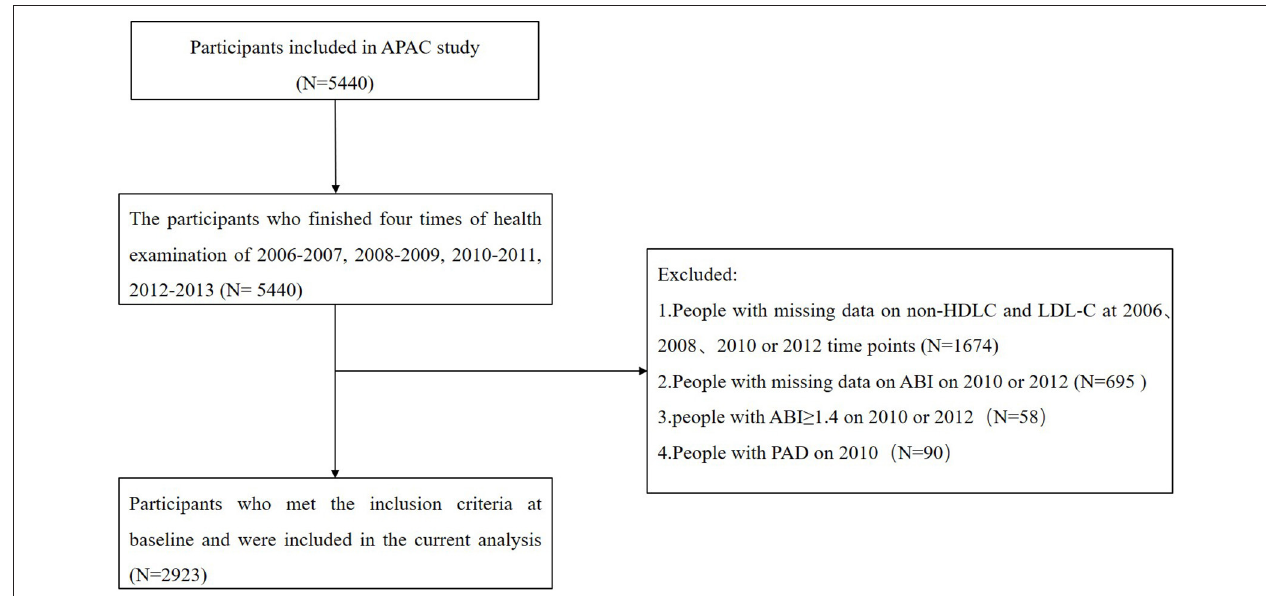
FIGURE 1 | Study flow